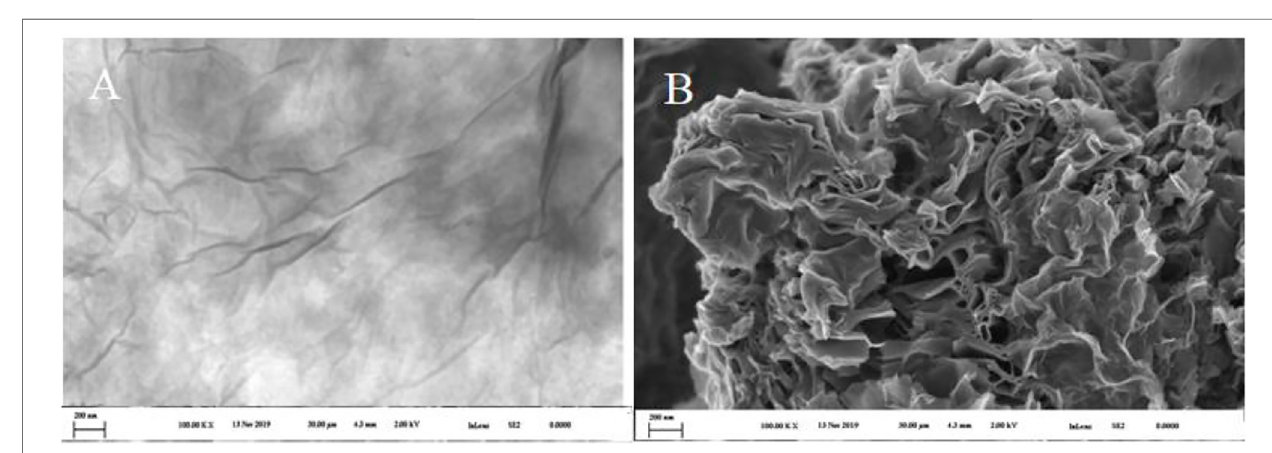
FIGURE 3 | SEM for the GO (A) and 3D GF-CS (B) .